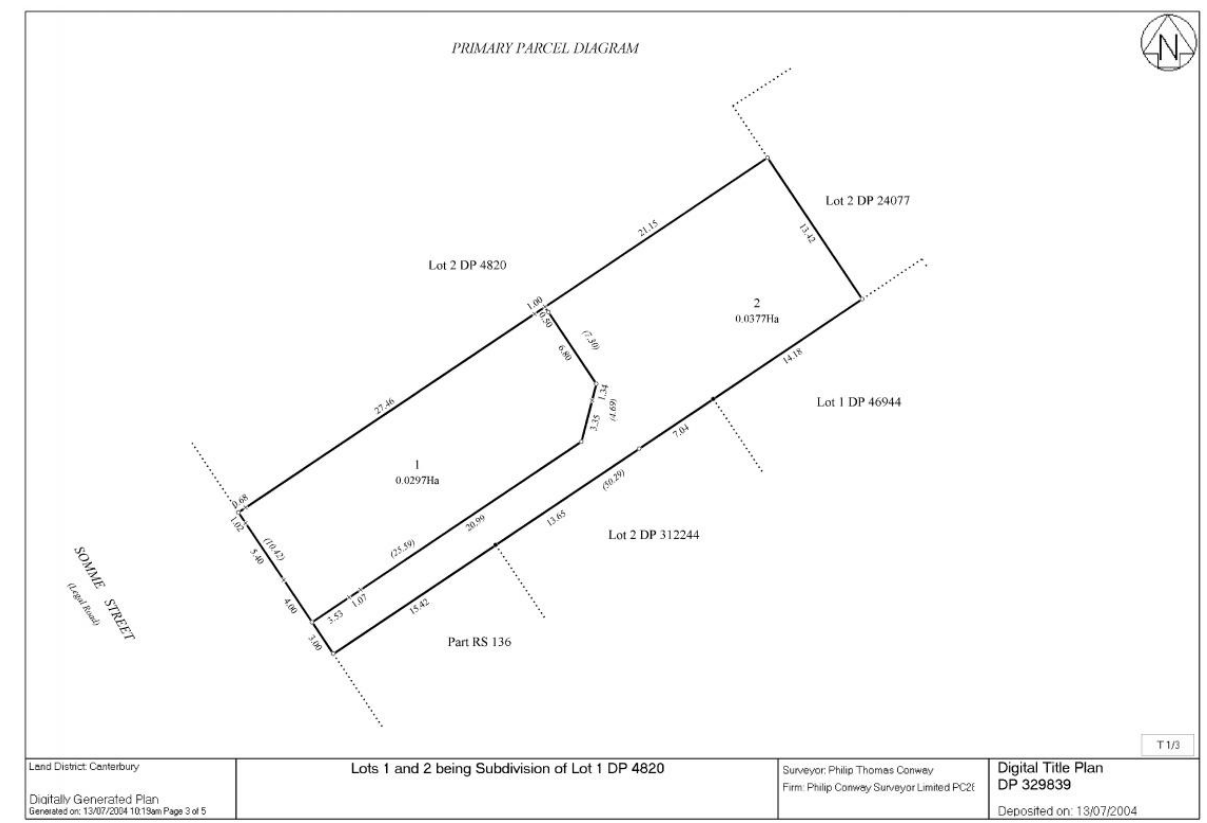
Figure 8. Cadastral Survey Plan. Source: [34].